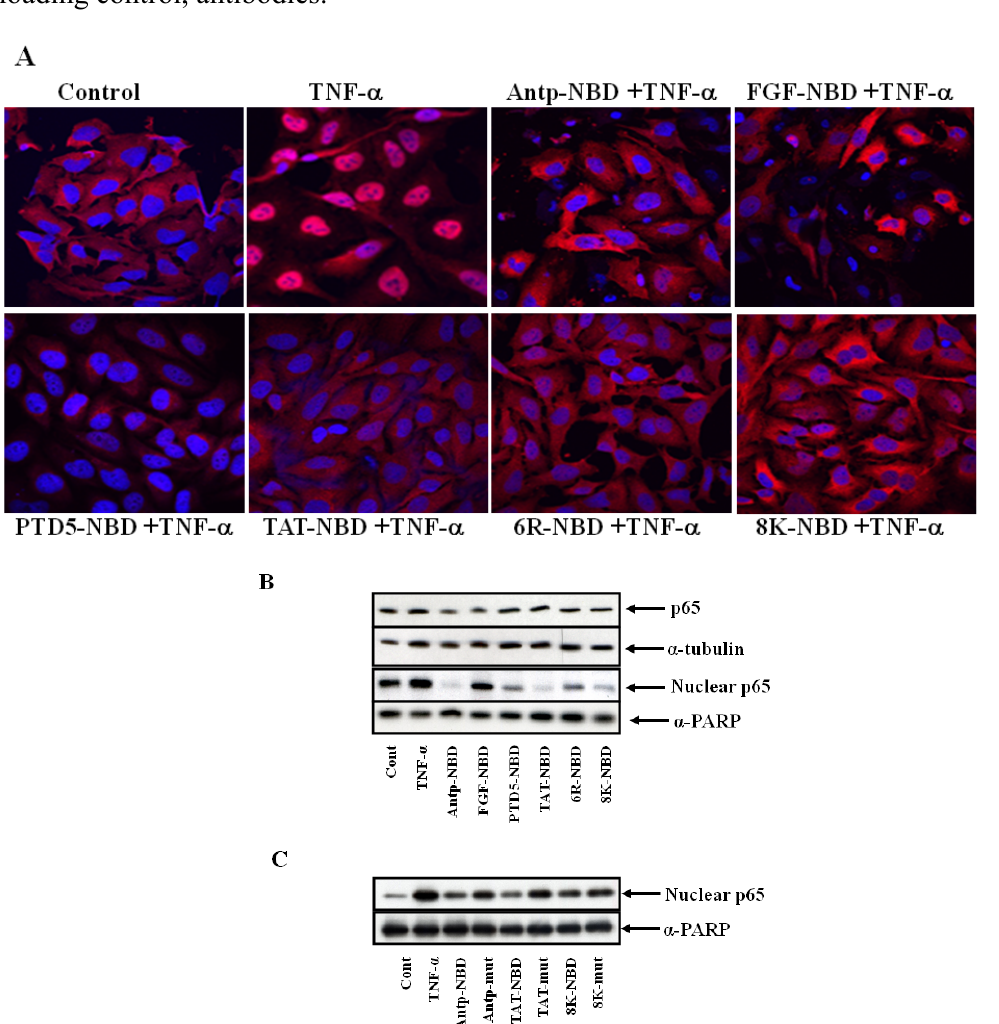
Figure 4. Inhibition of p65 translocation with NBD peptides. Panel A showing immunohistolochemical analysis of inhibition of p65 nuclear translocation with PTD NBD peptides . HeLa cells were incubated with the 100 µM of PTD-NBD peptides for 1 h, then stimulated with TNF- α (10 ng/mL) for 3 h or left untreated. The cells were fixed and immunostained for p65 (red) with nucleus counter stained (blue). (Panel B): Panel B and C showing western blot analysis of PTD-NBD peptide inhibition of TNF- α activated NF- κ B binding to nucleus. 293 cells were incubated with 100 µM of PTD NBD peptides for 30 min and subsequently exposed to 10 ng/mL of TNF- α for 1h or left untreated as indicated. Cell extracts were prepared, and nuclear and cytosolic proteins separated as described in methods. The proteins were separated by SDS-PAGE and Western blotting with anti-p65 antibodies, and alpha tubulin (cytoplasmic loading control) and PARP (nuclear loading control). To confirm the NBD sequence is responsible for NF- κ B suppression, 293 cells were incubated with 100 µM of PTD NBD peptides (either WT or mut attached to various PTDs) for 30 minutes and subsequently exposed to 10 ng/mL of TNF- α for 1h or left untreated as indicated (Panel C). Nuclear cell extracts were prepared, and the proteins were separated by SDS-PAGE and Western blotting with p65 and PARP, as a loading control,